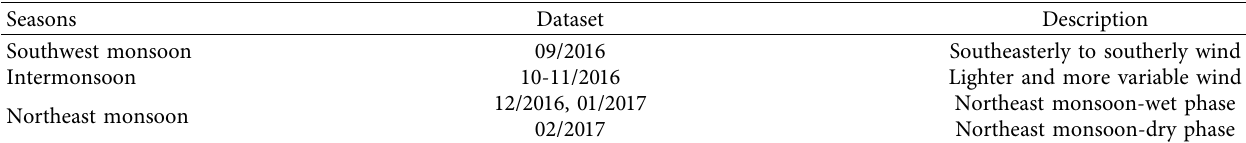
Figure 2: An example of four different flight trajectories reflecting speed, heading change, and hold maneuver in the sample data for sector 2E. Table 1: Singapore seasonal information of the dataset.